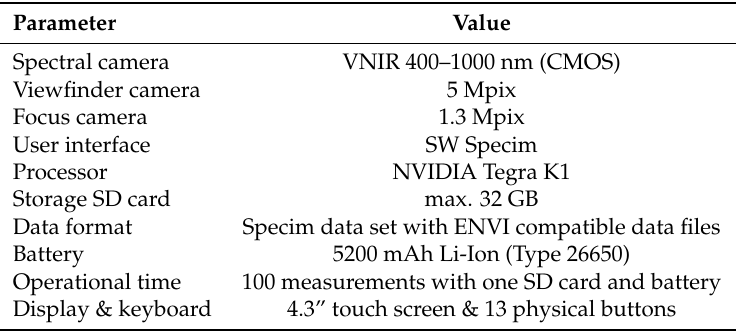
Table 1. Specim IQ technical